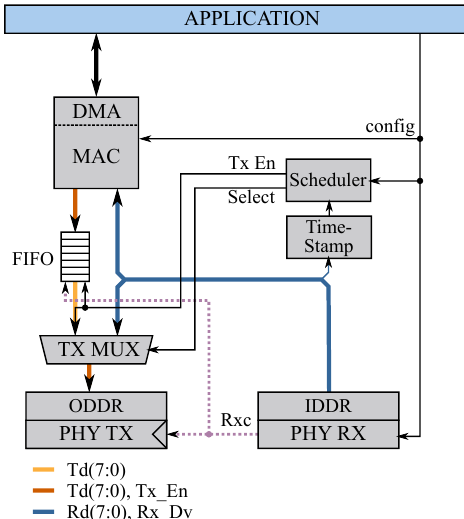
Figure 6. Details of the slave node interface implementation for a dual-phase ring protocol (broadcast and data collection phases). During the broadcast phase, the logic directly connects the incoming data to the transceiver of the node second port.